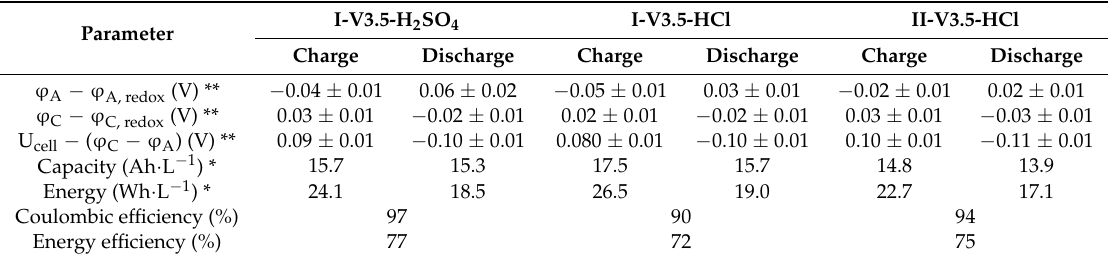
Table 4. Parameters for the cells evaluated in the cell test for HCl (I-V3.5-HCl, II-V3.5-HCl) and H 2 SO 4 (I-V3.5-H 2 SO 4 ) vanadium